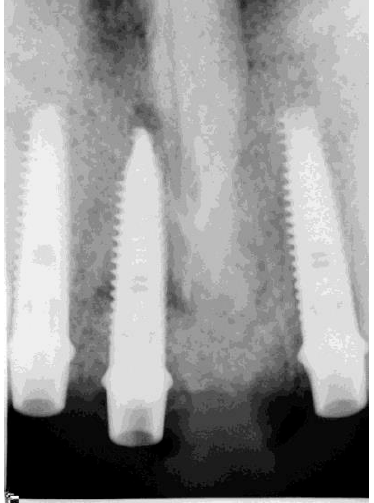
Figure 2. Radiographic verification of transfer adaptation.